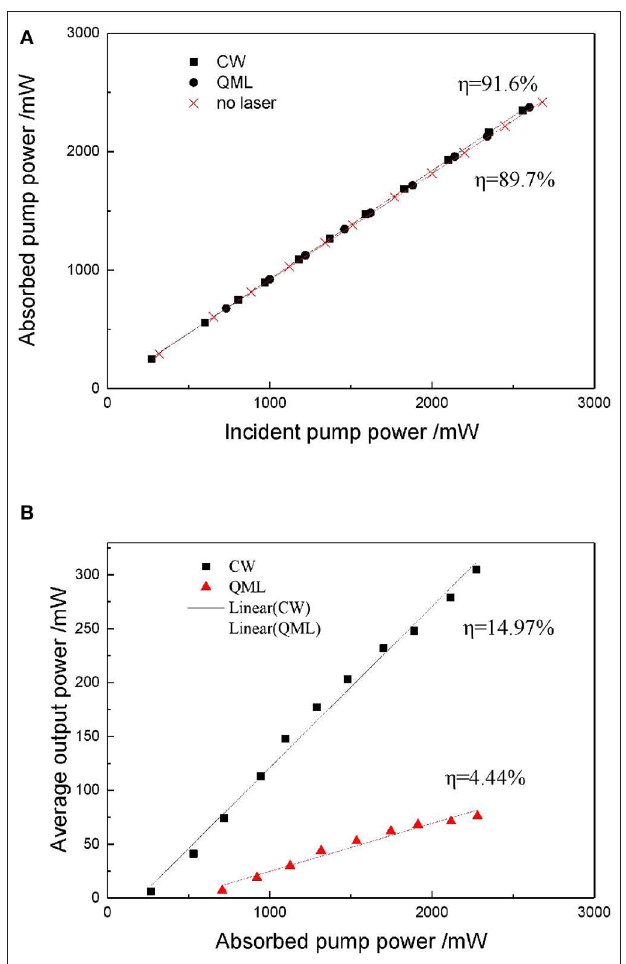
FIGURE 2 | Experimental data diagram. (A) The dependence of absorbed power on incident pump power. (B) The dependence of average output power on absorbed pump power under CW and QML.